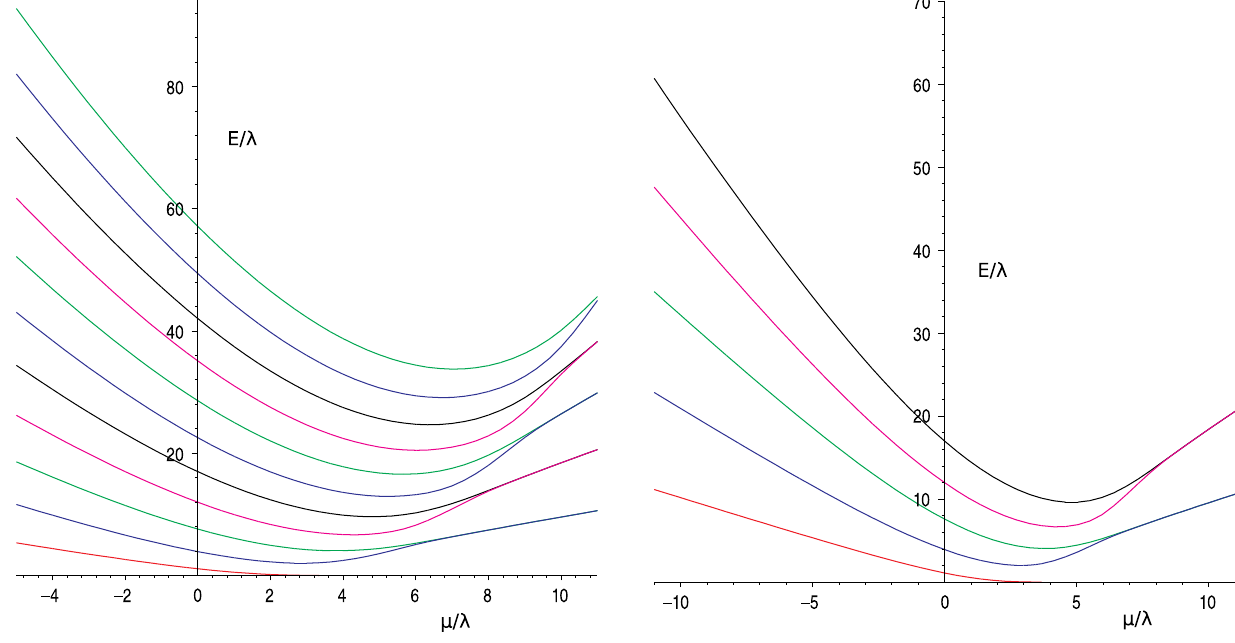
Fig. 1 Plot of the universal ratio E /λ for the first 11 eigenvalues as functions of μ/λ from − 5 to + 11